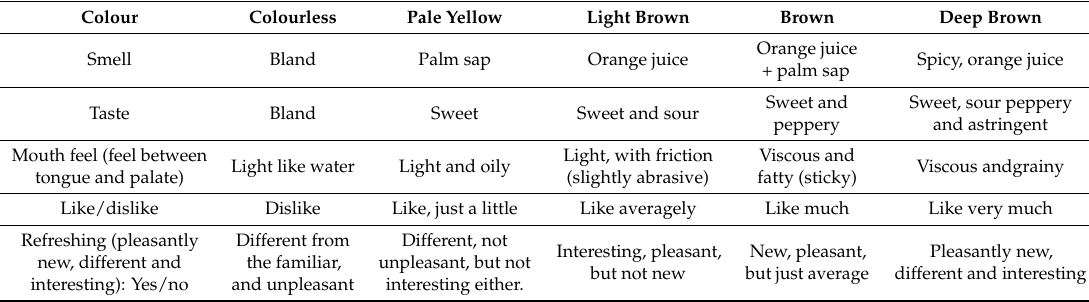
Table 2. Descriptive sensory evaluation